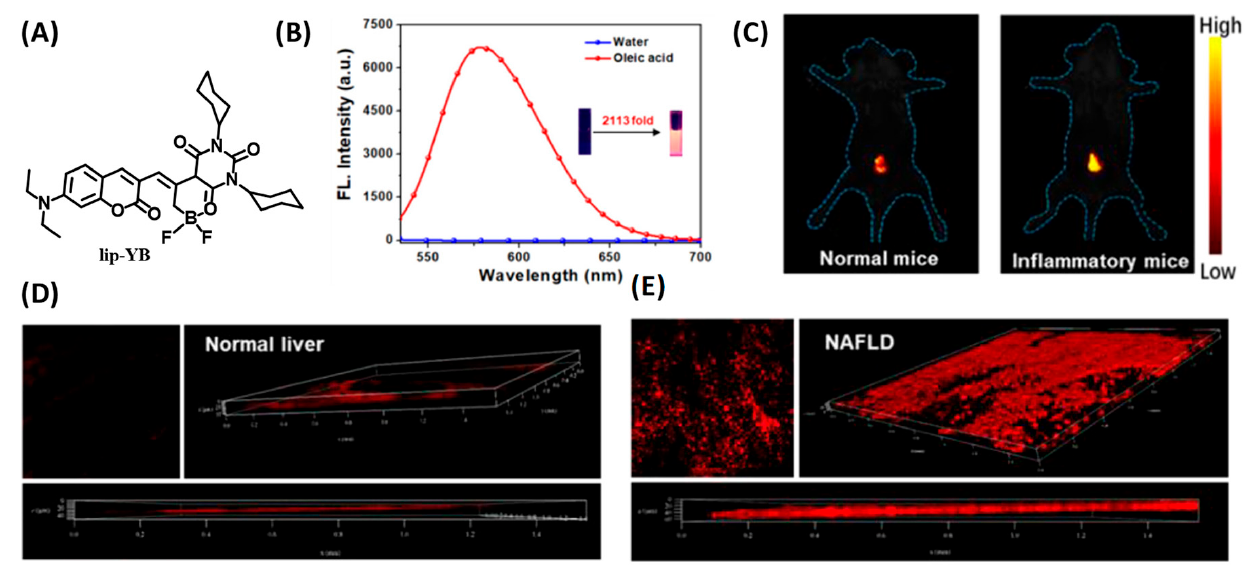
Figure 9. ( A ) Structure of lip-YB for lipid droplet tracking. ( B ) Emission spectra of lip-YB in oleic acid and water, and the inset shows photographs of lip-YB in H 2 O (left) and in oleic acid (right) taken under illumination using a UV lamp. ( C ) In vivo imaging of lip-YB in normal mice and inflammatory mice. ( D,E ) TP Fluorescence images of lip-YB in normal liver tissues and NAFLD tissues [39]. Copyright © 2023 American Chemical Society.